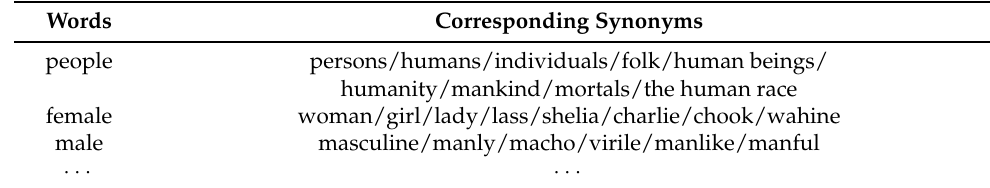
Table 3. Words and their synonyms.